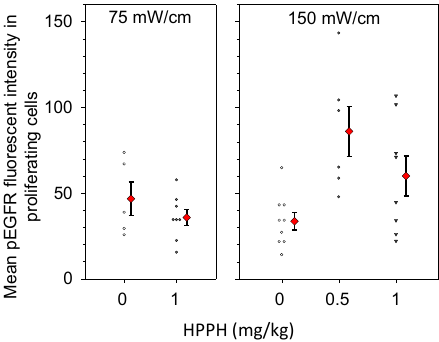
Figure 6. PDT increases EGFR activation in the proliferating areas of intrathoracic tumors treated with a fluence rate of 150 mW/cm. Immunohistochemistry was used to quantify levels of phosphorylated EGFR (pEGFR) in areas that were positive for proliferation by Ki-67 staining. Controls received no photosensitizer (0 mg/kg HPPH), but did receive illumination at the fluence rate that corresponded to the PDT condition. Treatment of the tumor-bearing thoracic cavity was to a total dose of 50 J/cm. Open symbols (controls) and closed black symbols (treatment groups) indicate the pEGFR staining intensity in individual mice. Red diamonds indicate the mean and standard error (error bars) for each group.